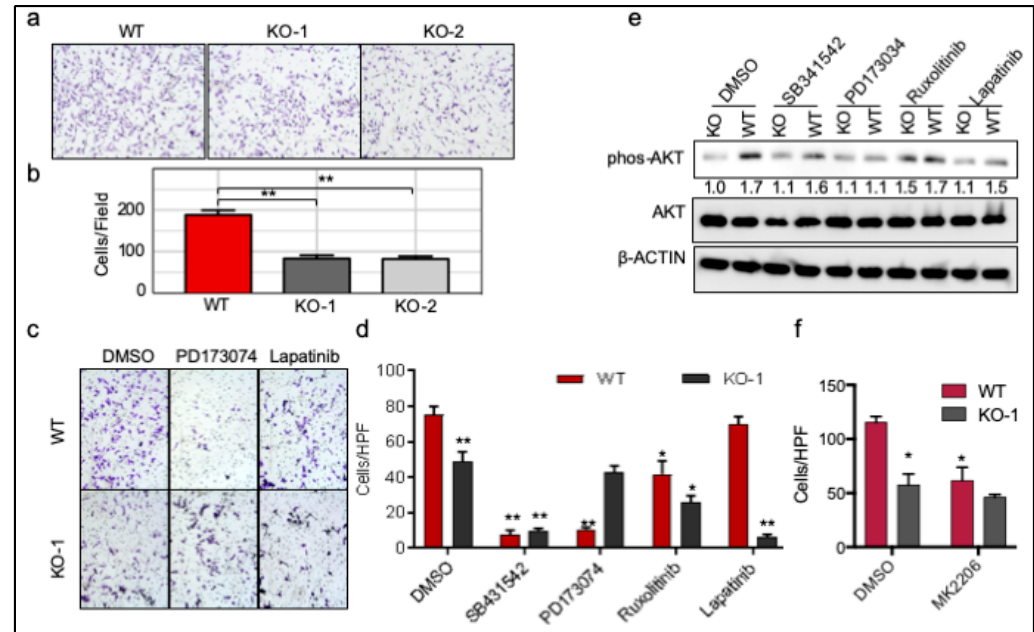
Figure 6. ROR1 regulates invasion through FGFR1 in BLBC cells. ( a ) Cells in Figure 5a were used for invasion assay. Scale bar represents 200 µ m. ( b ) The graph represents the average cell number / microscopic field ( n = 3). ( c , d ) WT or KO Cells were plated for invasion assay and treated with control DMSO, SB-431542 (5 µ M), PD173074 (50 nM), ruxolitinib (10 µ M), or lapatinib (100 nM) for 24 h. Representative images were shown ( c ) and quantitated ( d , shown as mean ± SD, n = 3–4). ( e ) WT or KO Cells were treated with same set of inhibitors for 2 hours in the complete media. Cells lysates were collected for immunoblotting with pAKT and AKT, with β -ACTIN as a loading control. ( f ) WT or KO Cells were plated for invasion assay and treated with control DMSO or AKT inhibitor MK2206 for 24 h and quantitated. Data shown as mean ± SD ( n = 3), * p < 0.05, ** p < 0.01.